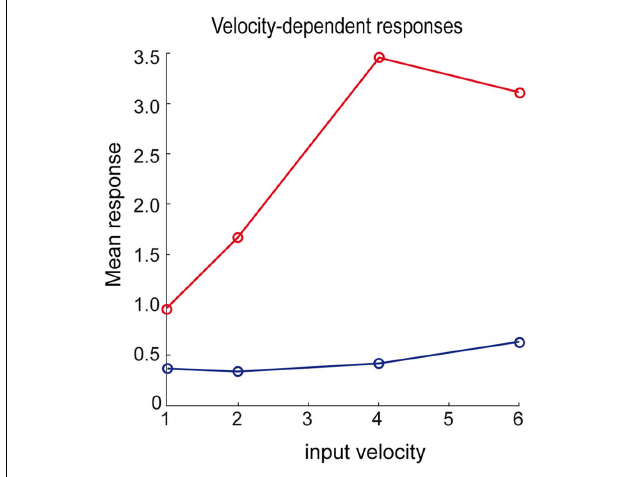
FIGURE 8 |Velocity-dependent responses of the dendrite for the inward (red) and outward (blue) sequence. We modeled the response by the mean over the inferred time-dependent propagation rate (see right column of Figure 7 ) at four different speeds of the input